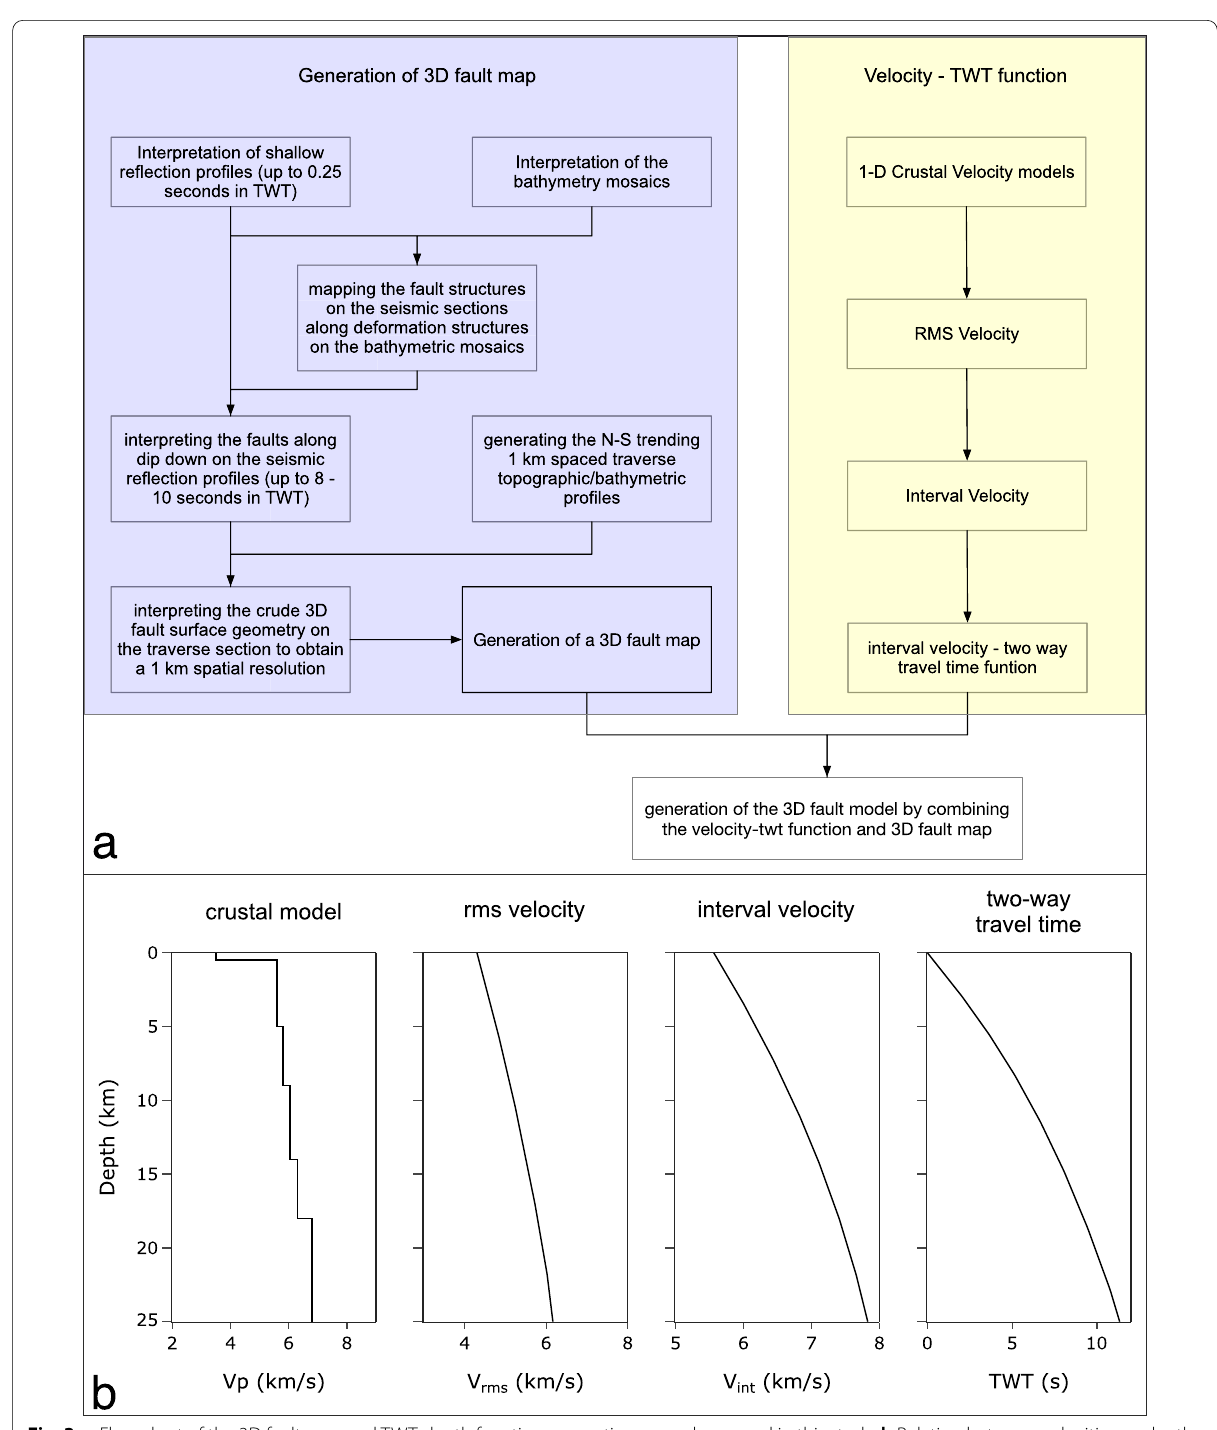
Fig. 3 a Flow chart of the 3D fault map and TWT-depth function generation procedures used in this study. b Relation between velocities vs. depth and two-way travel time vs. depth used in this study (crustal model from Bulut et al.